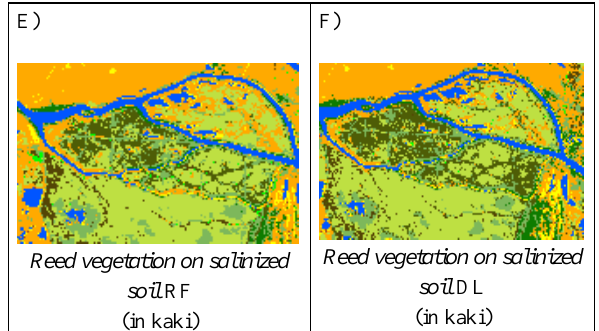
Figure 7: Comparisons of the mapping of the three classes of vegetation in the classifications of RF and